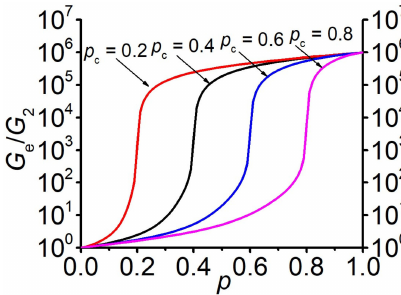
2 for various values